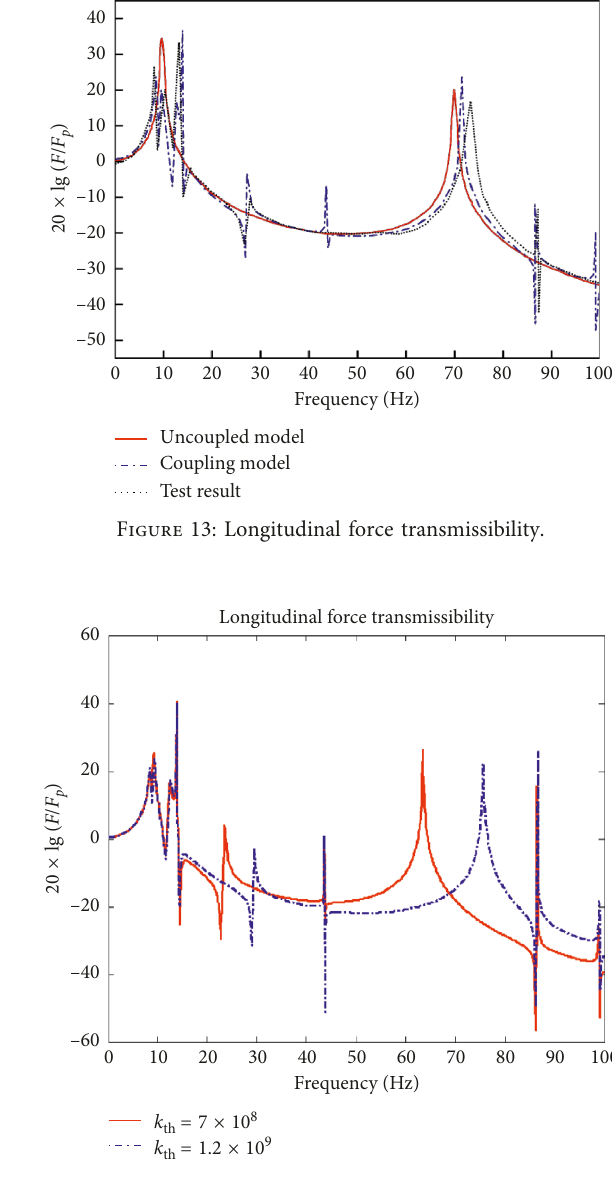
Figure 14: Longitudinal force transmissibility under different stiffness of thrust